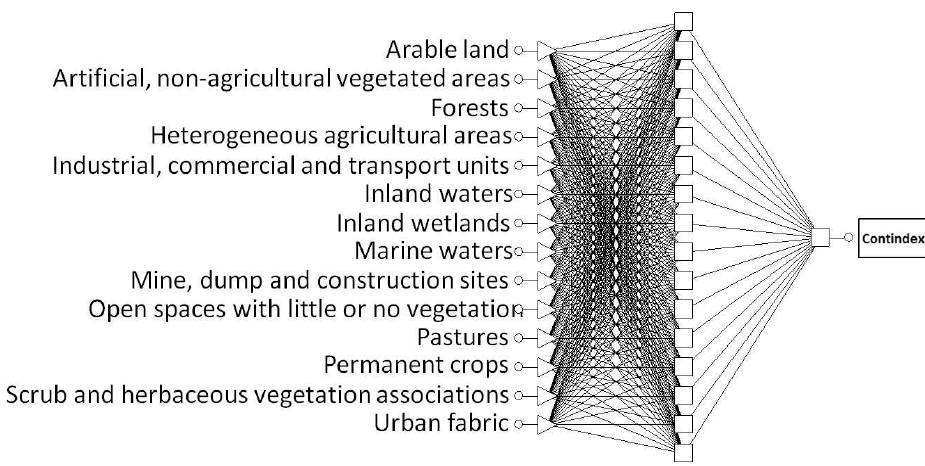
Figure 2. Optimal structure of ANN type MLP: 14-16-1 for CONT_IN.